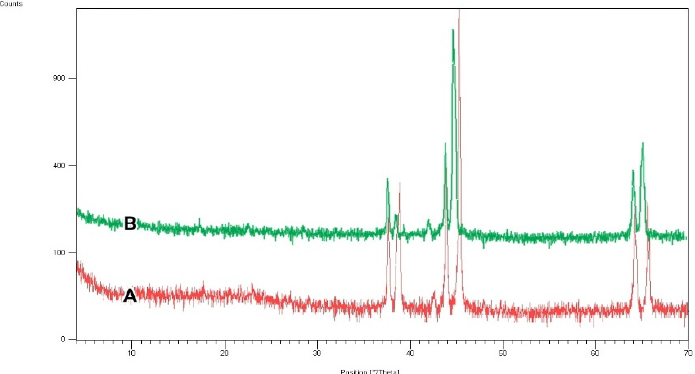
Figure 3. XRD spectra of ( A ) untreated, ( B ) atmospheric-air plasma-treated gelatin nanofibers.